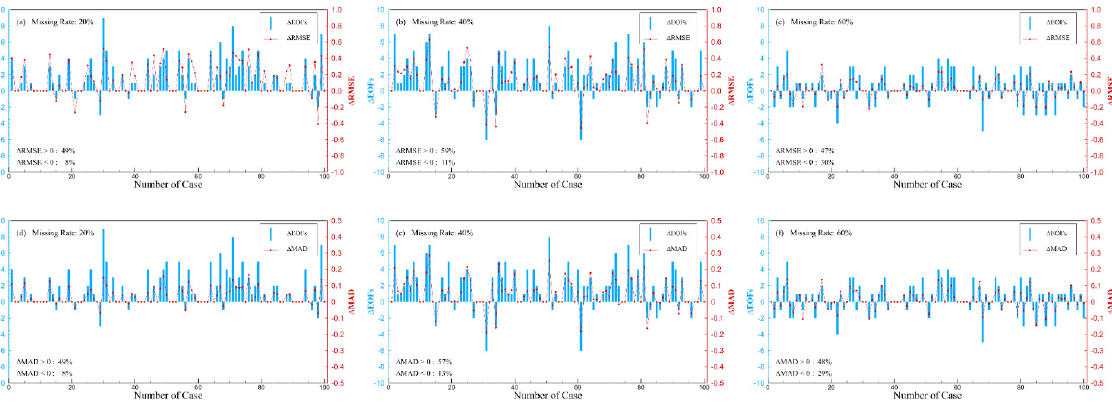
Figure 10. The differences of SSIM, r, and MAD ( a , d , g missing rate: 20%; b , e , h : missing rate: 40%; and c , f , i missing rate: 60%).